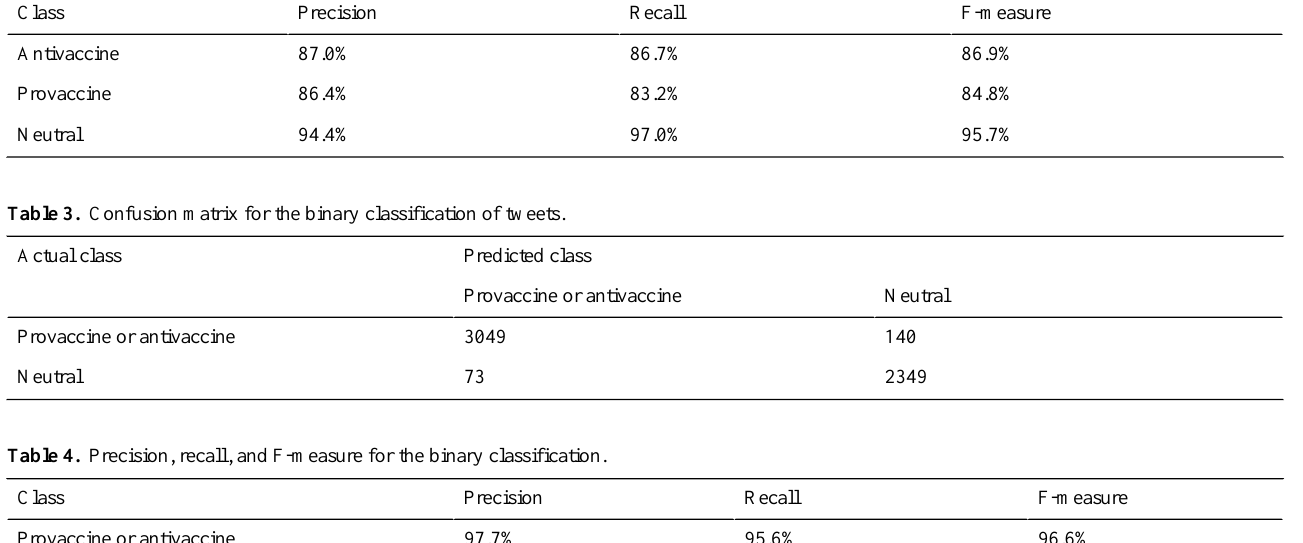
Table 2. Precision, recall, and F-measure for the three classes of tweets. F-measureRecallPrecisionClass